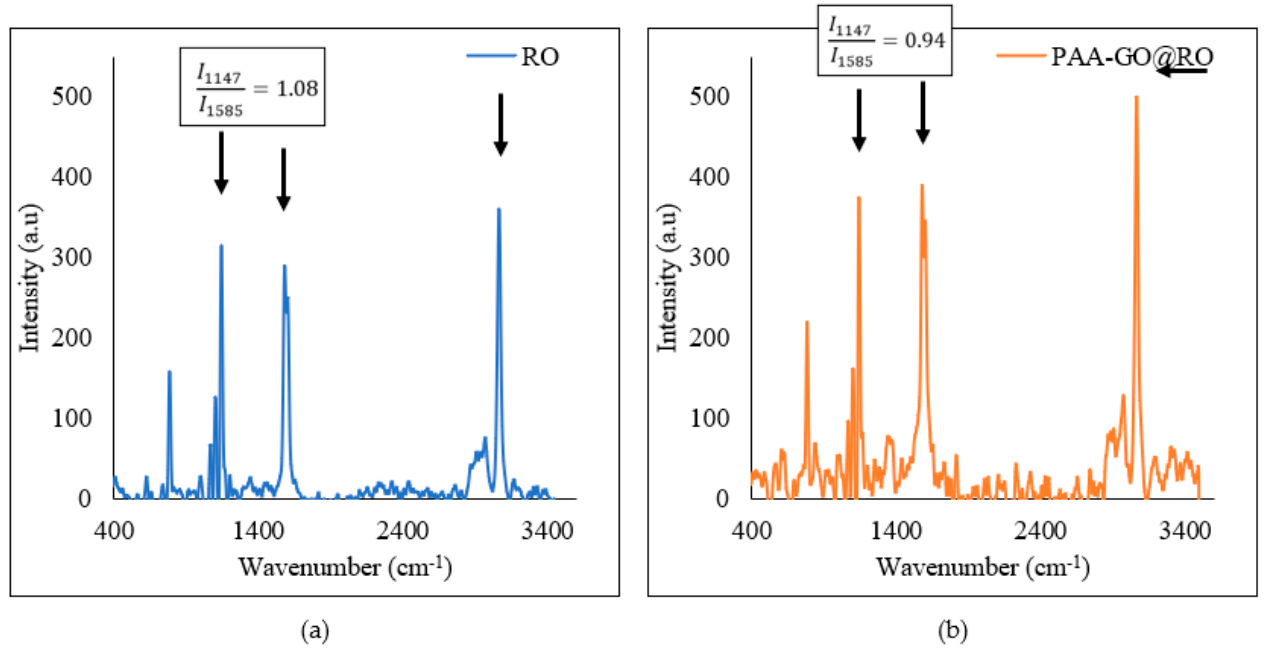
Figure 10. Raman spectra of the membranes ( a ) bared RO membrane; ( b ) PAA-GO@RO optimized membrane.